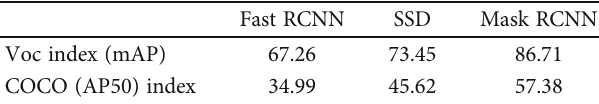
Figure 8: Schematic diagram of magnetic fi eld waveform disturbance when a vehicle passes through a dual sensor node. Table 1: Comparison of target test results.